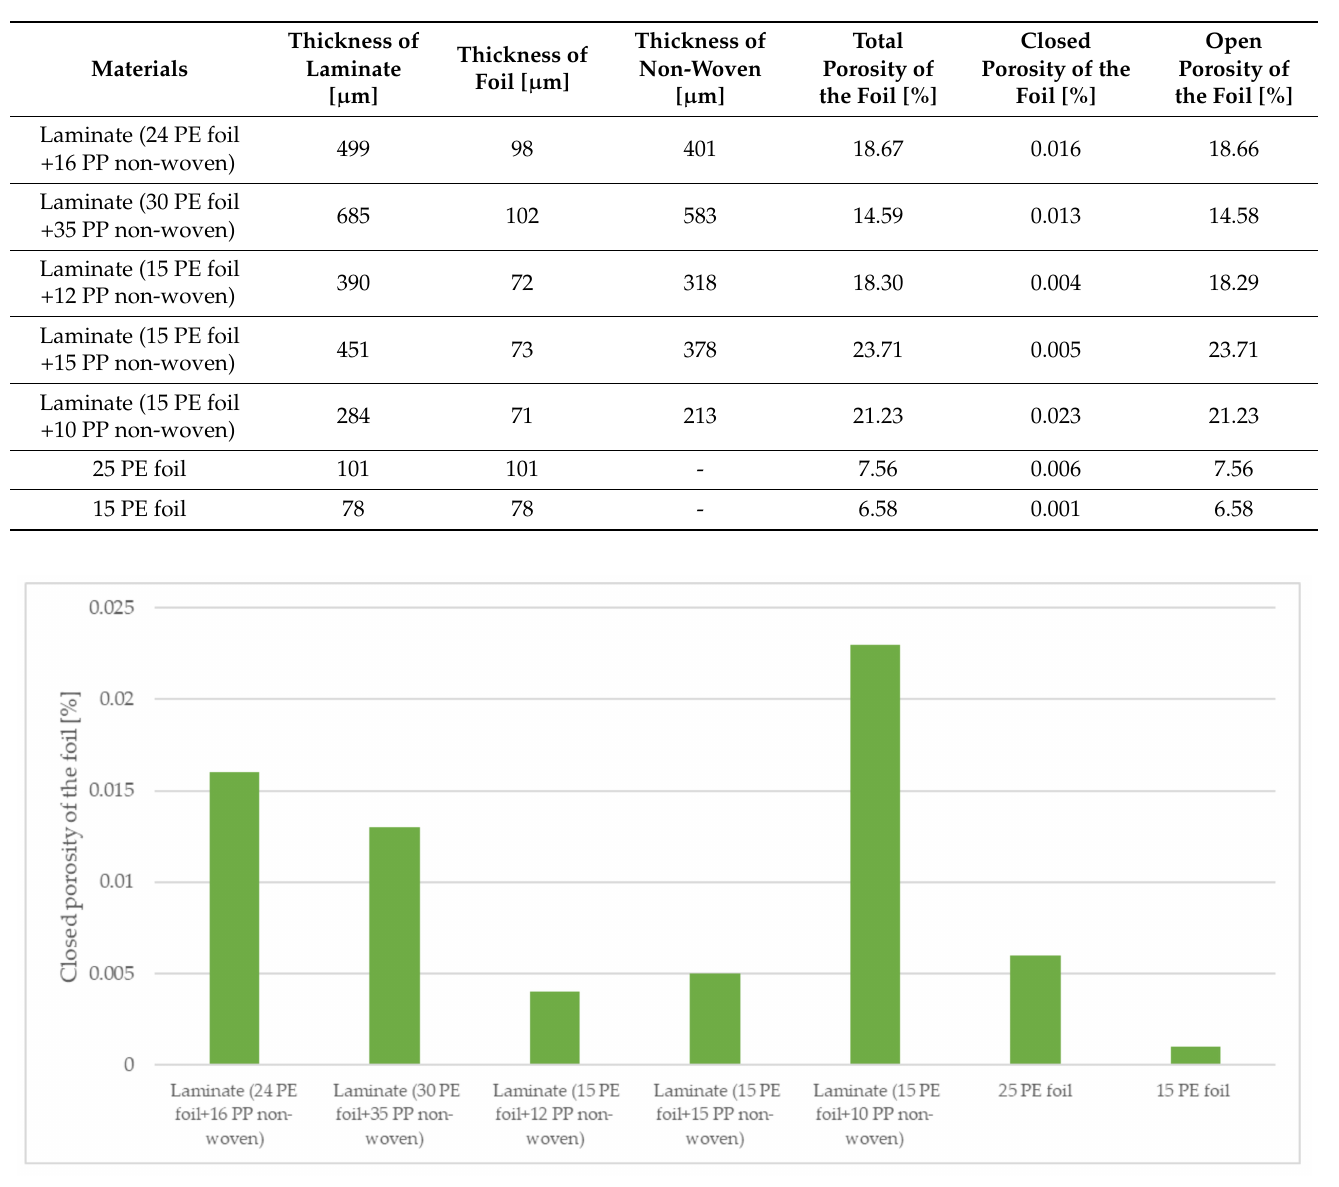
Table 3. Results from micro-CT test—porosity of vapor-permeable membranes.